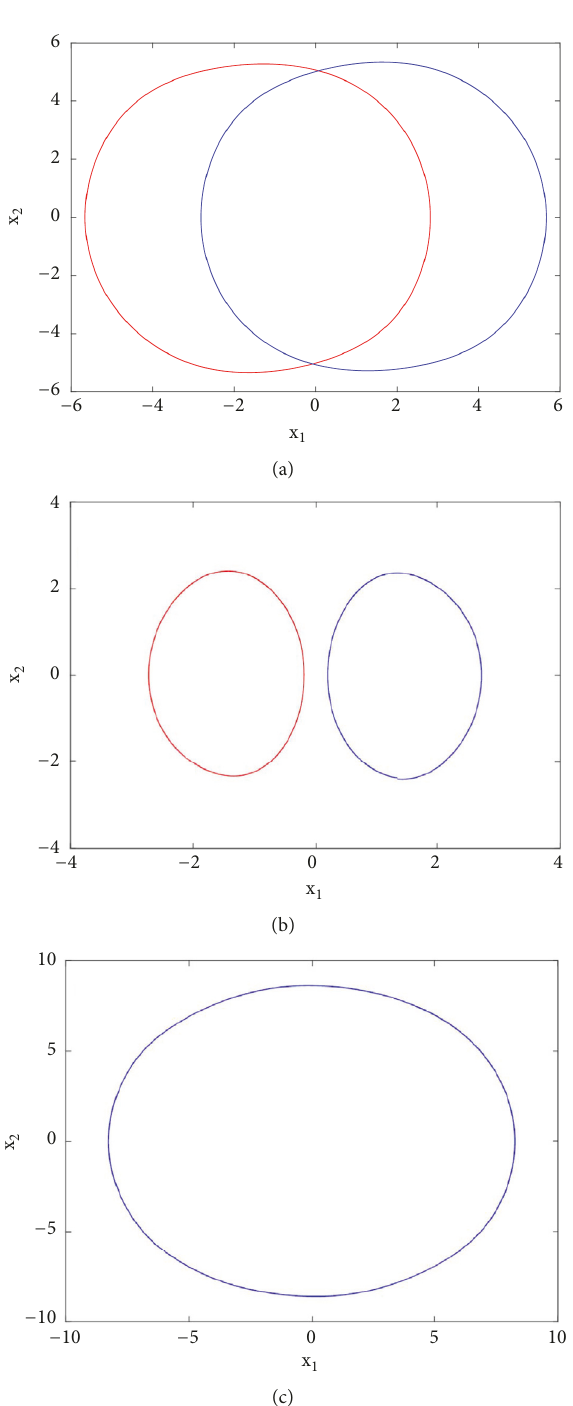
Figure 9: Coexistence of five different period-1 limit cycles for a 2 = 3 with the rest of system’s parameters as follows: b = a 1 = 3, a 0 = 1.75, a 3 =1, a 4 = 0.0054. Initial states are given in Table